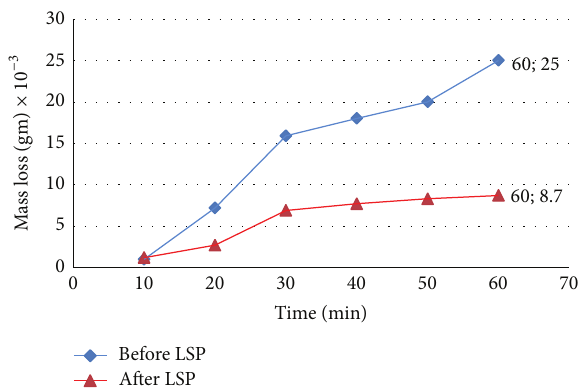
Figure 8: Variation of the mass loss on 2024-T3 specimens before and after LSP treatment with time.